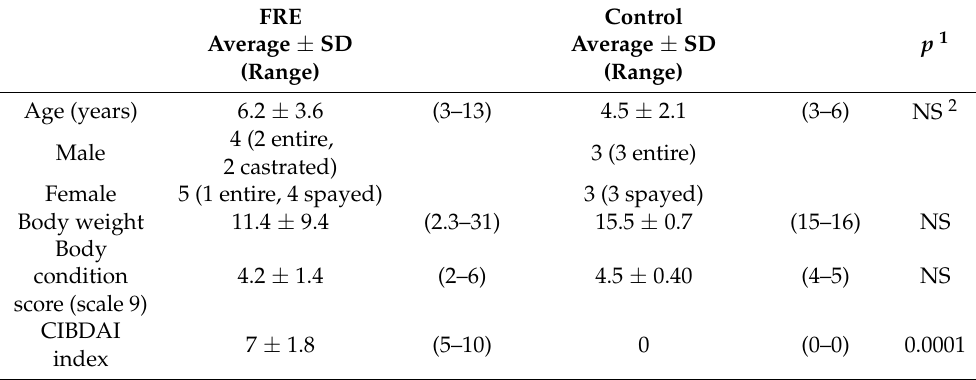
Table 1. Data of signalment and CIBDA index (chronic enteropathy activity index) in the dogs with FRE (food-responsive enteropathy) and control dogs included in the